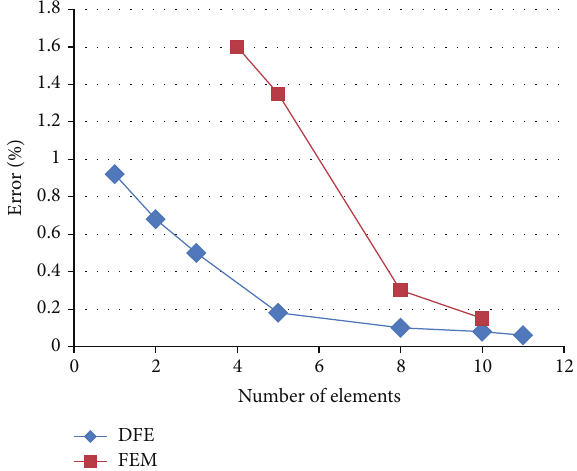
Figure 4: Convergence analysis for cantilevered beam, with 𝑃 = = 0 (5th natural frequency); DFE method versus con- 1.23 MN, 𝑀 𝑧𝑧 ventional